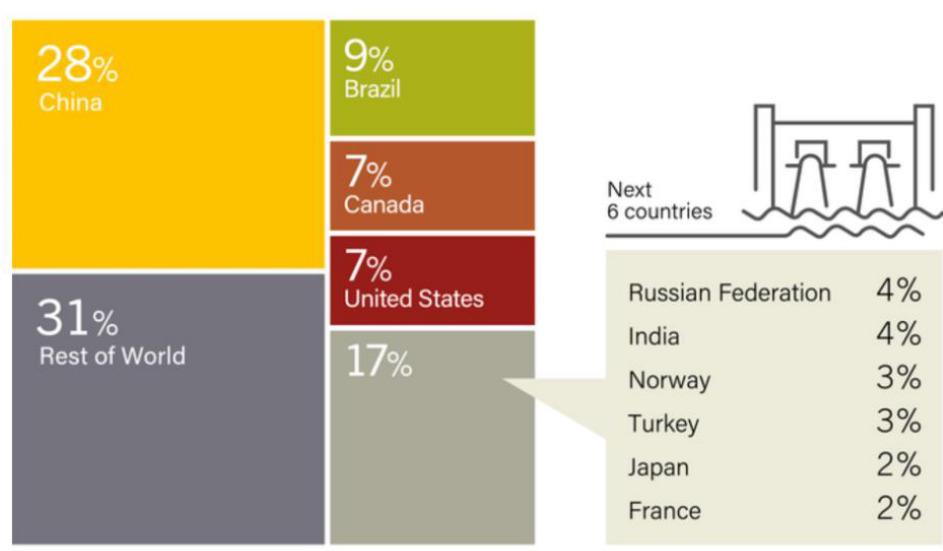
Figure 5. Hydropower global capacity, shares of top 10 countries and the rest of world, 2019 [18]. As an energy storage technology, pumped hydro storage combines many attractive traits that augment the simple comparison of Table 1. In a recent (July 2021) report by the National Renewable Energy Laboratory (NREL), PHS charge/discharge cycles were found to take from several hours to days, with a reaction time from several seconds to minutes, and a round trip efficiency of more than 80% [19]. The report showed that PHS systems (the upper right-hand corner in Figure 6) absorb all supply/demand discrepancies with